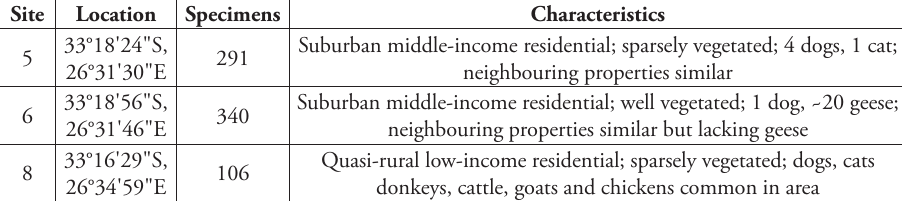
Table 1. Locations and characteristics of monitoring